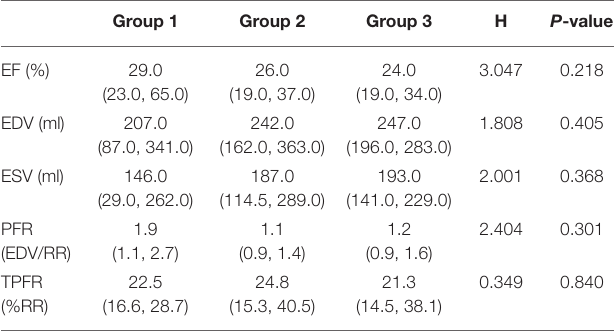
TABLE 2 | Comparison of left ventricular functional parameters among groups [median (25th,75th)].